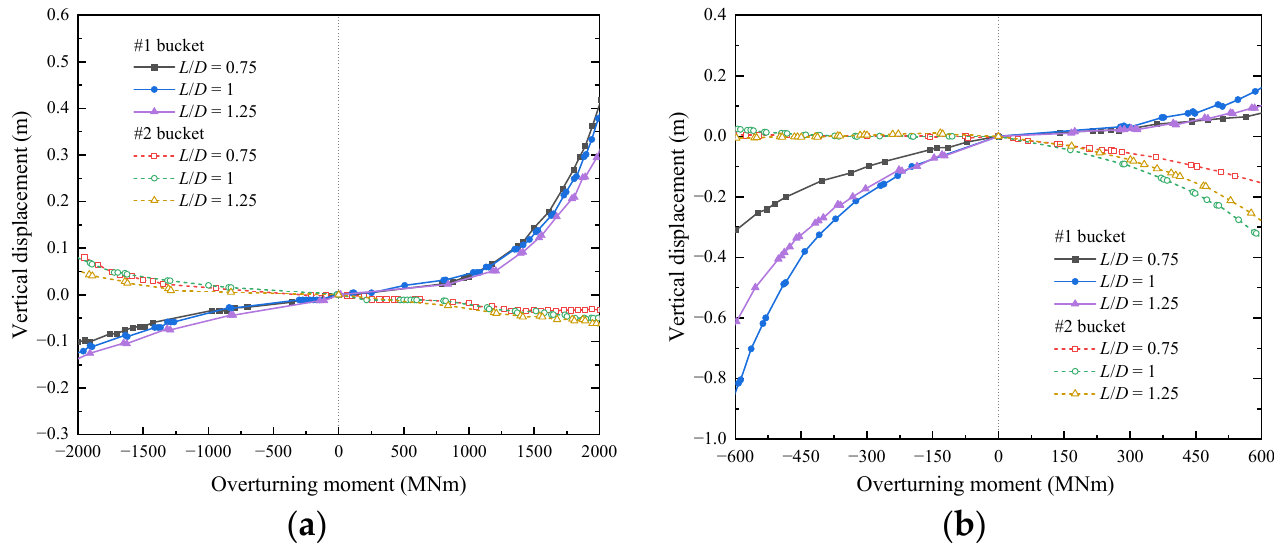
Figure 15. Vertical movement response of bucket: ( a ) sand, ( b ) soft